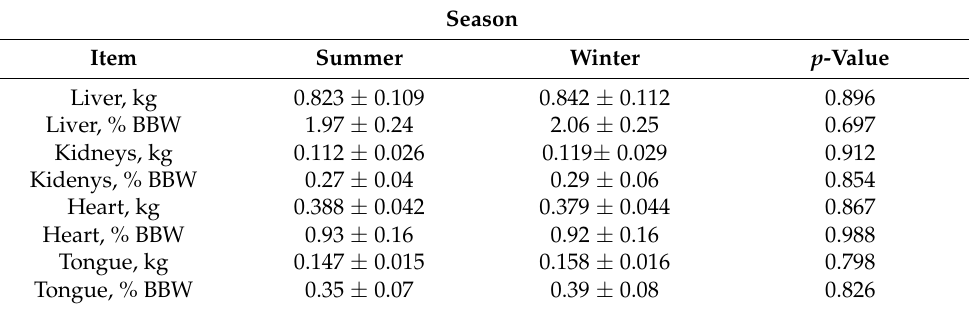
Table 2. Seasonal variation in the proportion of edible internal organs in the bled body weight (LSM ± SE).